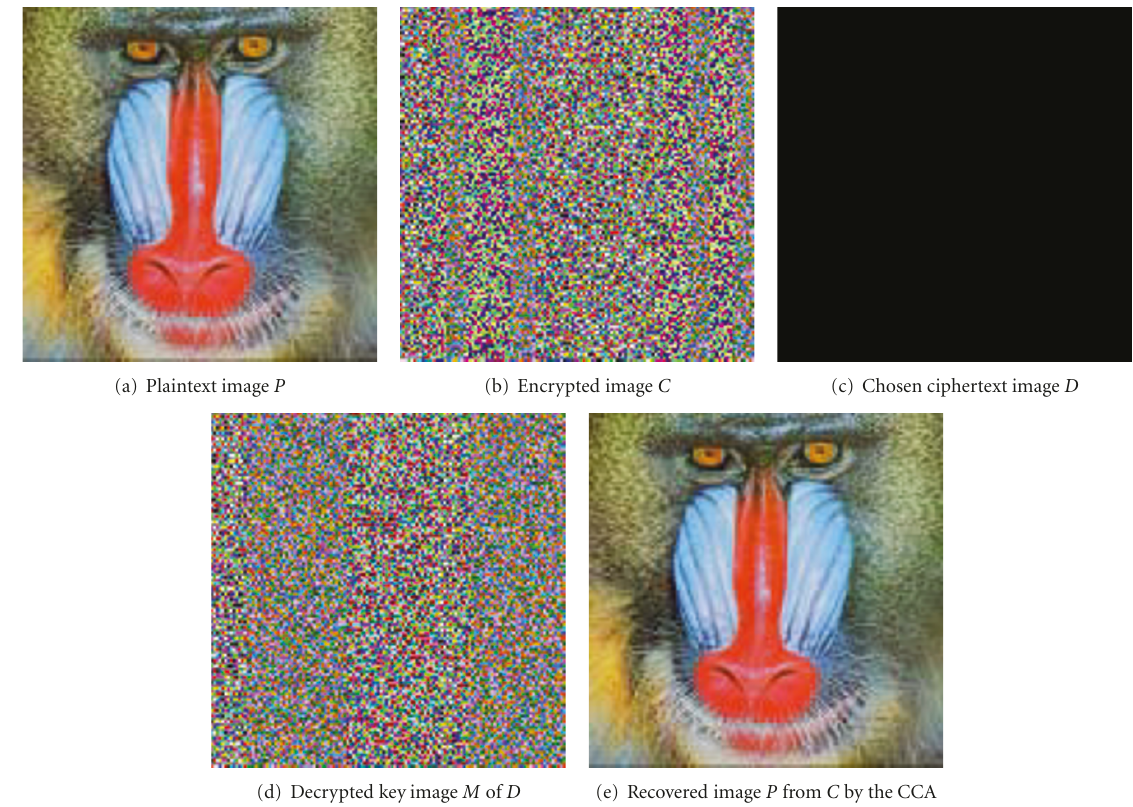
Figure 5: Simulations results of chosen-ciphertext attack (CCA): (a) plaintext image P ; (b) encrypted image C ; (c) chosen ciphertext image D ; (d) decrypted key image M of D and (e) recovered image P from C by the CCA.